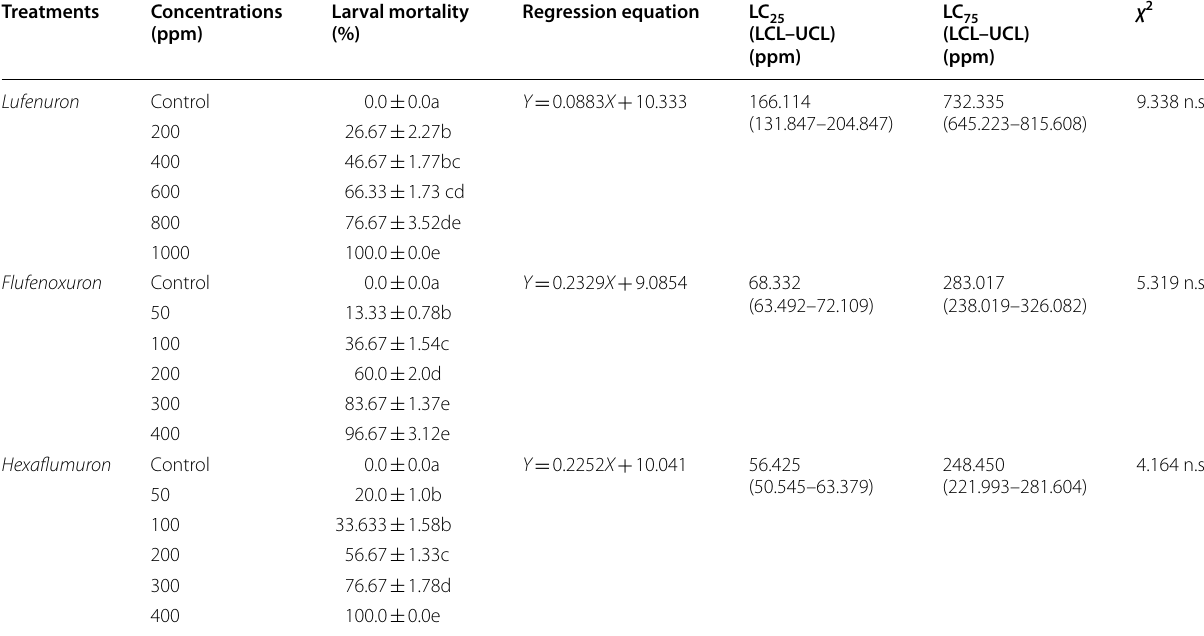
Larval mortality presented as Mean SD of three replicates, means with different letters are significantly different P < 0.05. (LC 25 ) concentration that kills 25% of ± population, (LC 75 ) concentration that kills 75% of population, (LCL) lower confidence limit, (UCL) upper confidence limit, χ 2 Chi-square, (n. s.) not significant at Alpha =